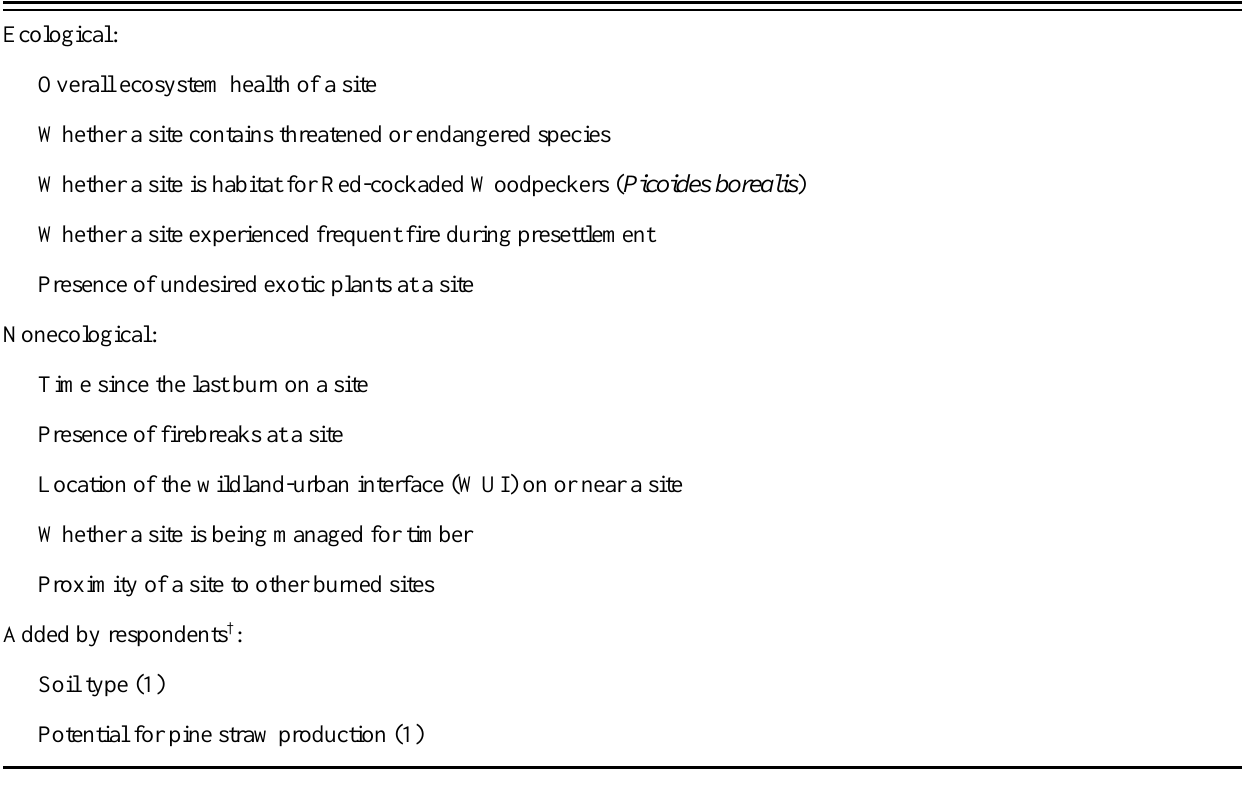
Table 1. Ecological and nonecological burn priority criteria named by focus group participants and used in the online surveys, as well as criteria that were added by survey